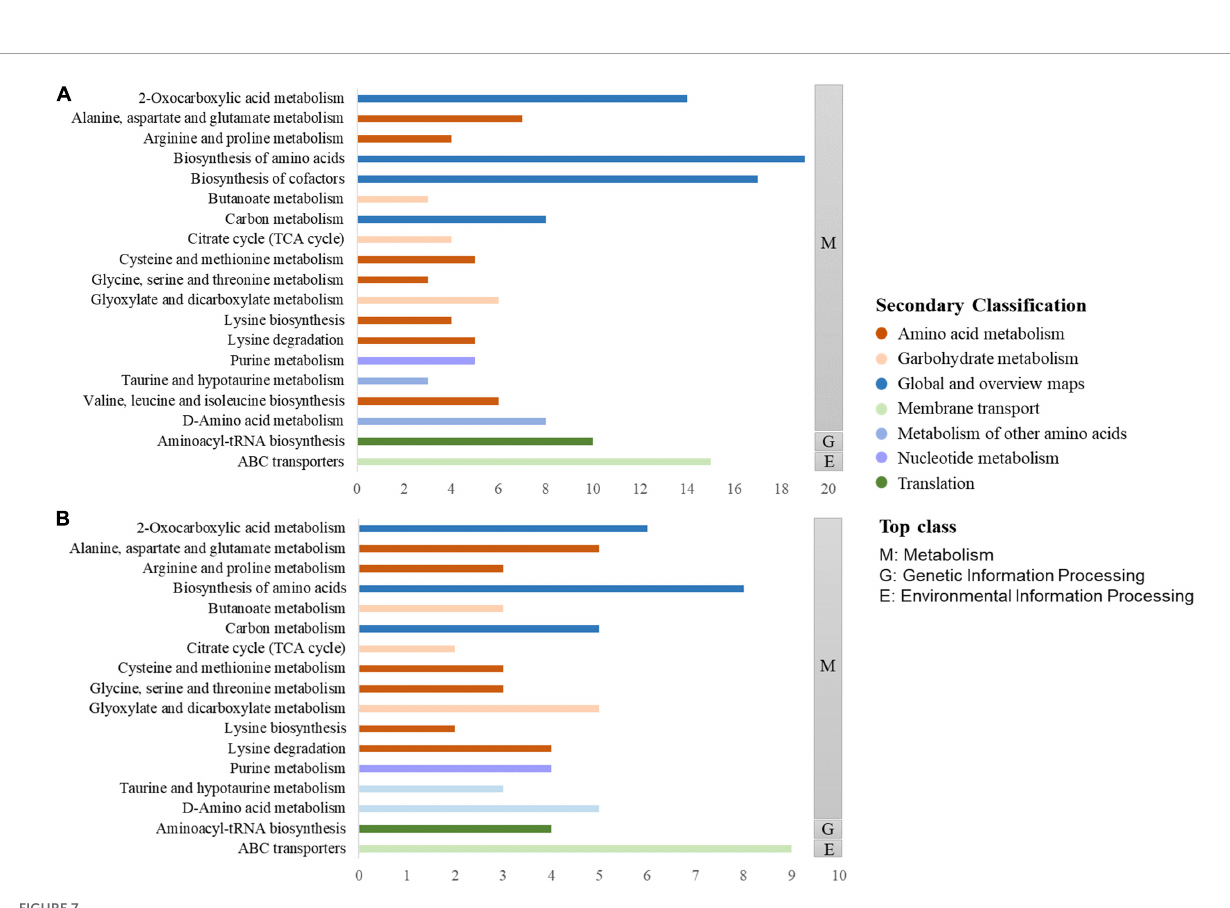
FIGURE7 KEGG enrichment pathways of differential metabolites in Polygonati Rhizoma fermented by Lactiplantibacillus plantarum before and after fermentation (A) and under aerobic and anaerobic conditions (B) .